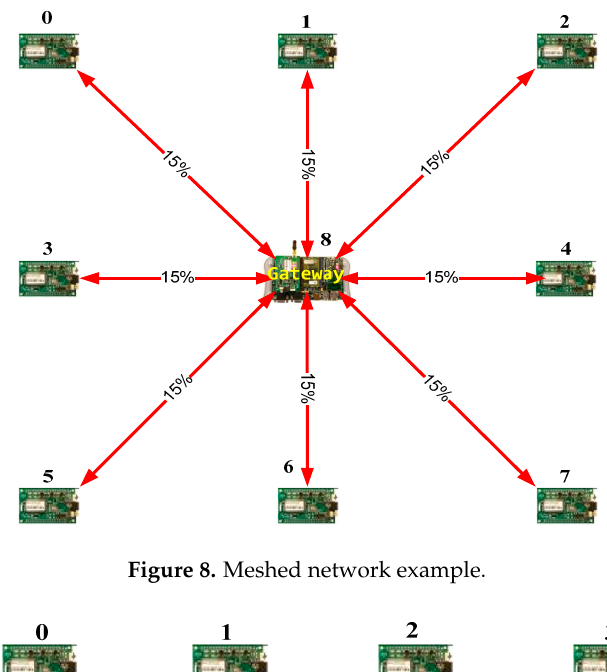
Figure 8. Meshed network example.